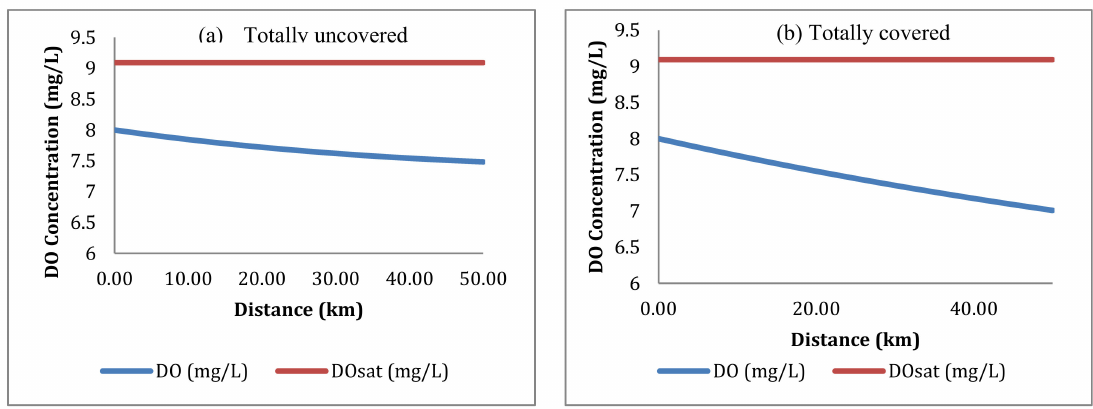
Figure 7. ( a ) and ( b ) The DO sag curve for the totally covered and totally uncovered cases in the winter.